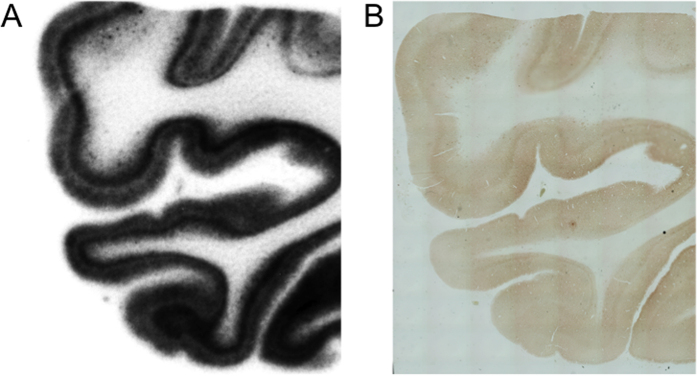
Magnified image of an in vitro autoradiogram with [125I]BIP-NMe2 (A) and immunohistochemical staining of the adjacent brain section with anti-phosphorylated tau antibody (B).